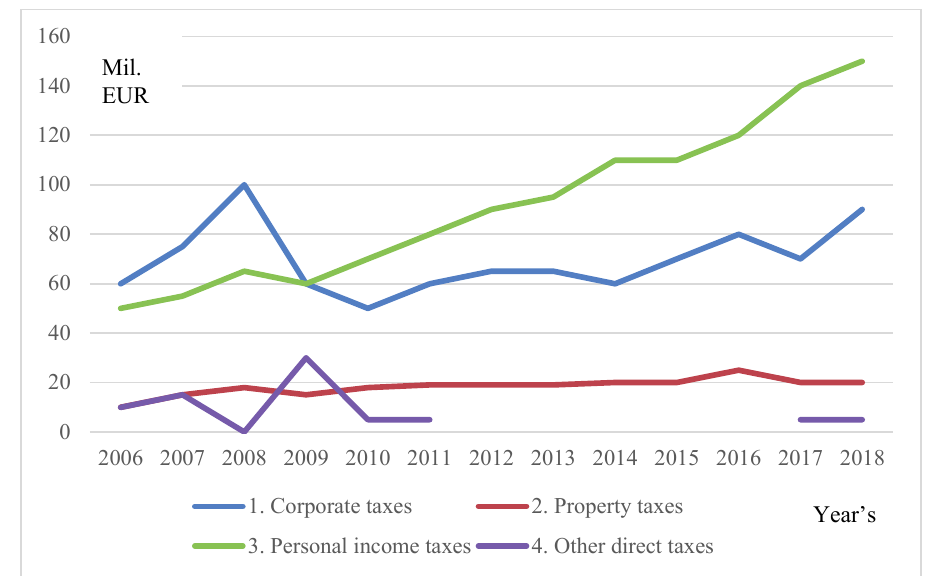
Fig. 3. Structure of direct taxes in the Republic of Kosovo in 2006–2018, million euros (Budget of the Republic of Kosovo, Ministry of Finance (MoF). Annual Financial Report of